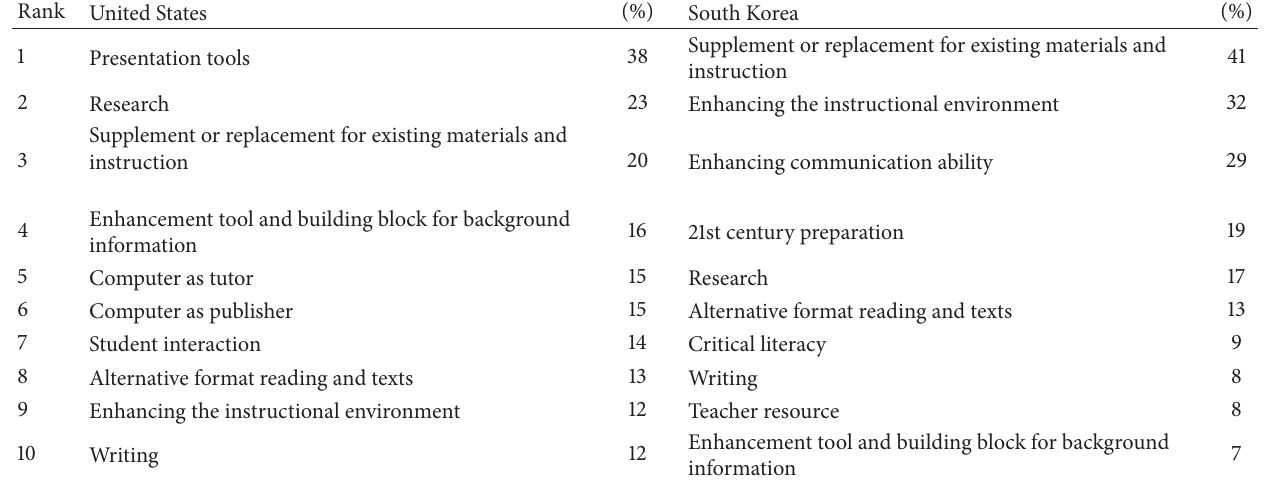
Table 4: Teachers’ ranked perceptions of ICT integration from coding of open-ended